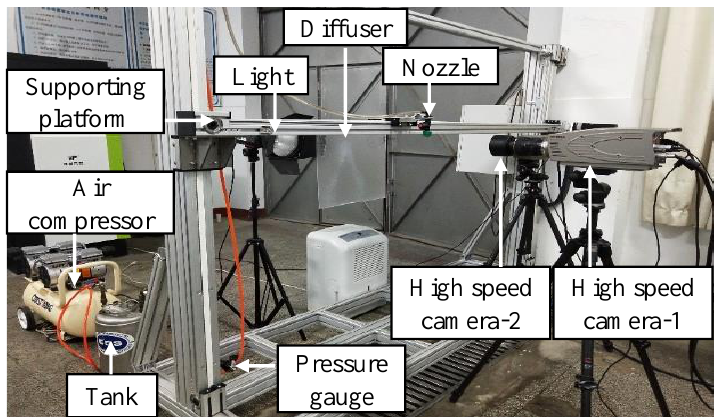
Figure 1. Image acquisition system based on two high speed camera and spray camera.